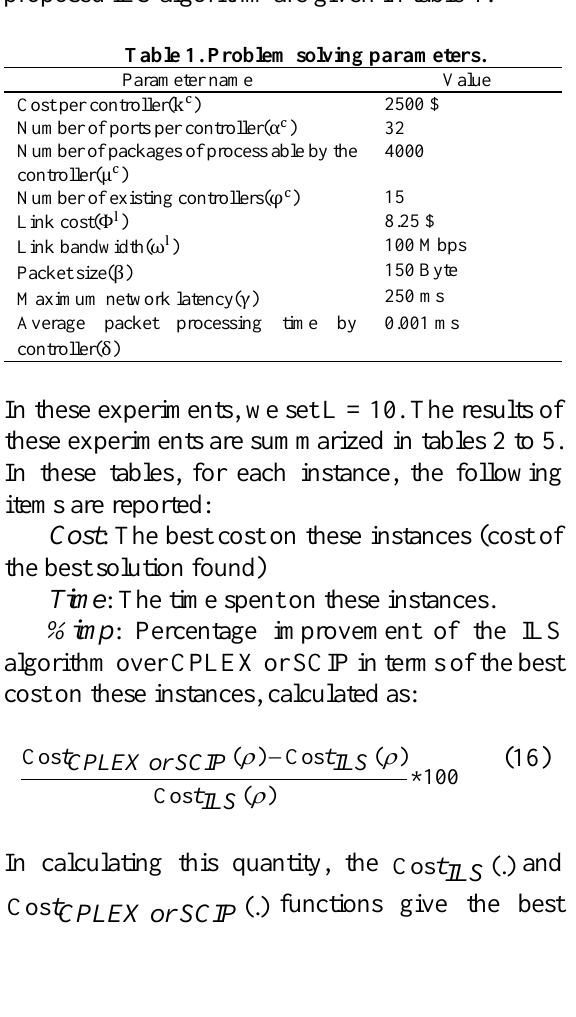
Table 1. Problem solving parameters.